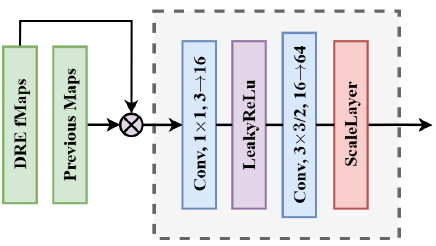
Figure 8. The architecture of the IIP module for HRNet32-OCR [44]. “Conv, 3 × 3/2, 16 → 64” means a 3 × 3 conv layer with stride = 2, channel input = 16, and channel output = 64. The ScaleLayer divides each element of the feature maps by a learnable parameter